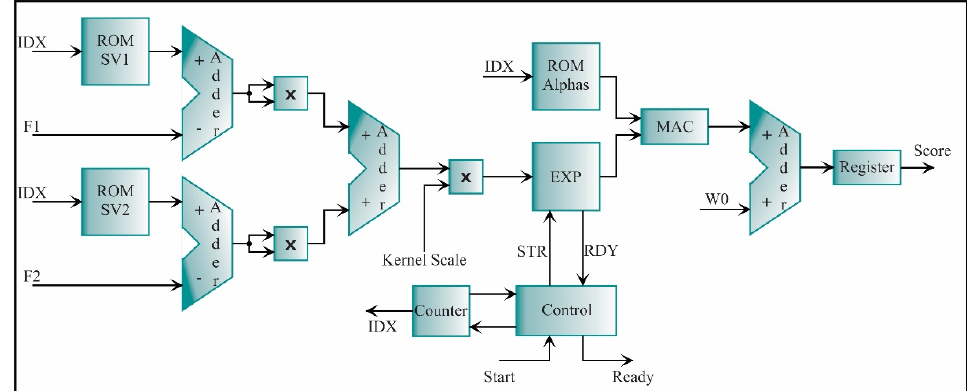
Figure 24. The architecture of the processing core for an SVM classifier.